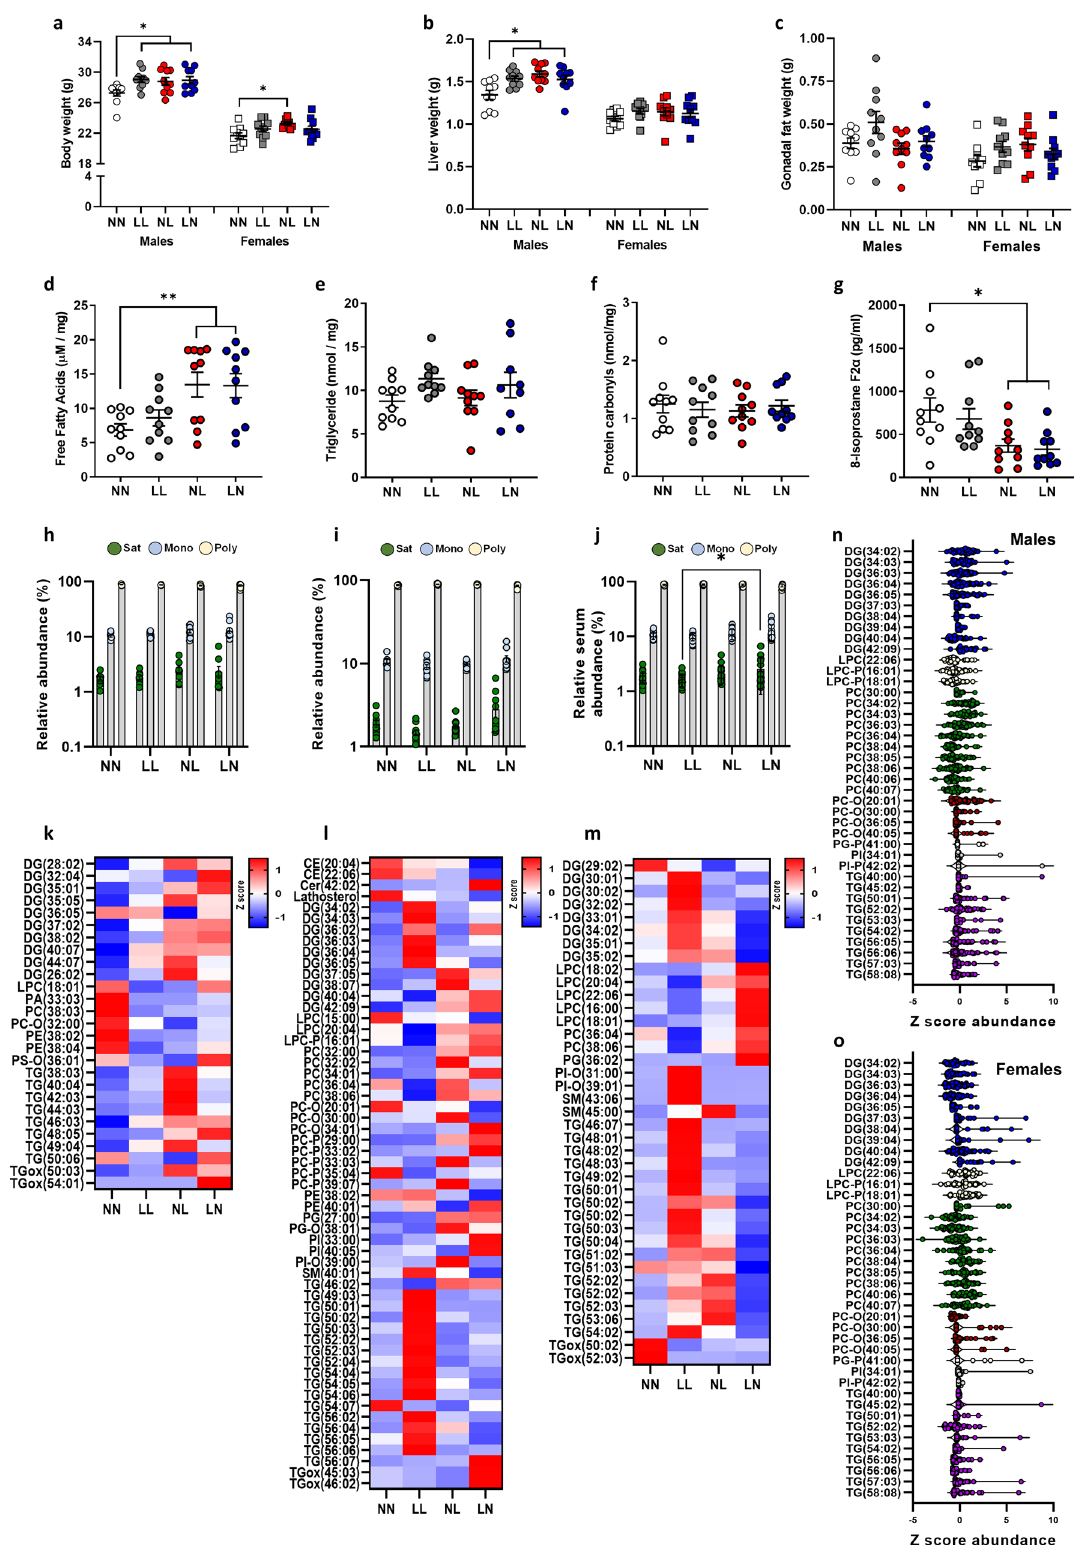
contrast, NL and LN offspring displayed a comparable pro fi le of lipids in the serum, with higher levels of diglycerides and triglycerides, matching changes seen in the gonadal fat, again with higher levels of diglycerides and triglycerides. In contrast, NL and LN offspring hepatic lipid pro fi les did not mirror each other, with the NL offspring matching the LL offspring more closely. As in